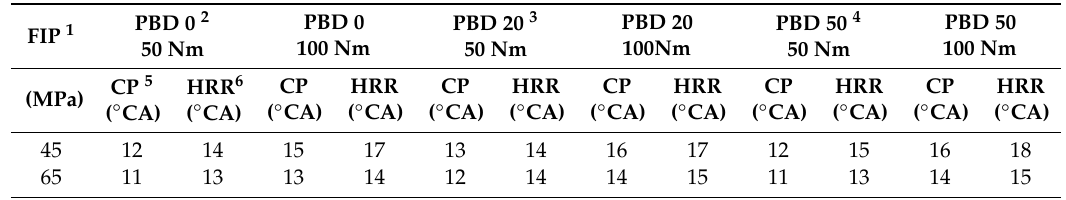
Table 4. Crankshaft angle (ATDC) of the maximum combustion pressure and heat release rate.